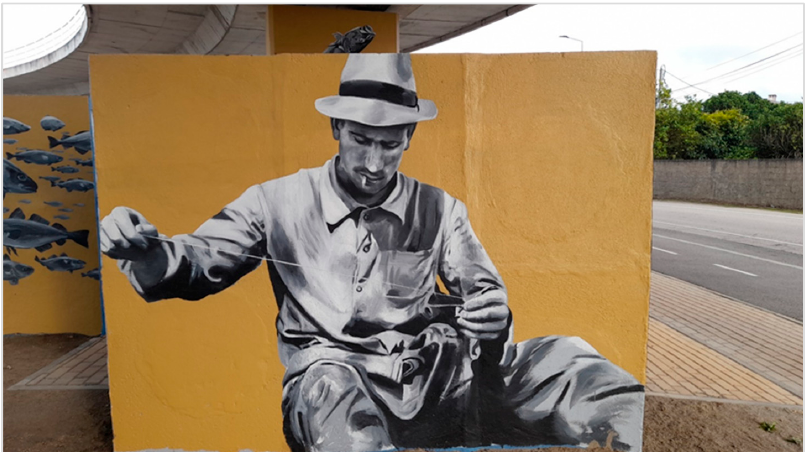
Figure 4. The fishing tradition: repairing fishing nets, by urban artist António Conceição, 2020